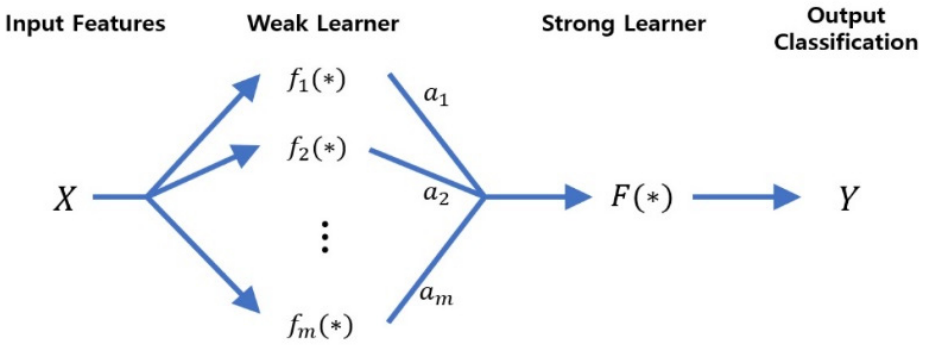
Figure 2. AdaBoost classifier model.